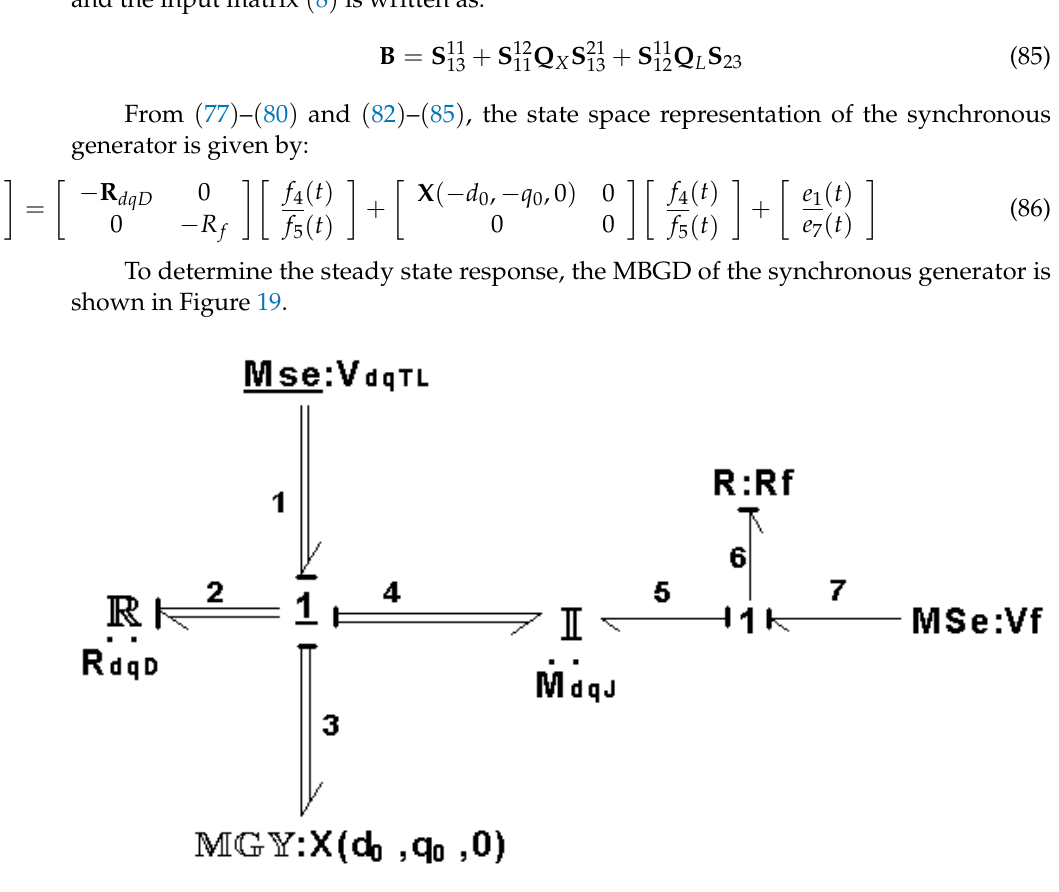
Figure 19. MBGD of a synchronous